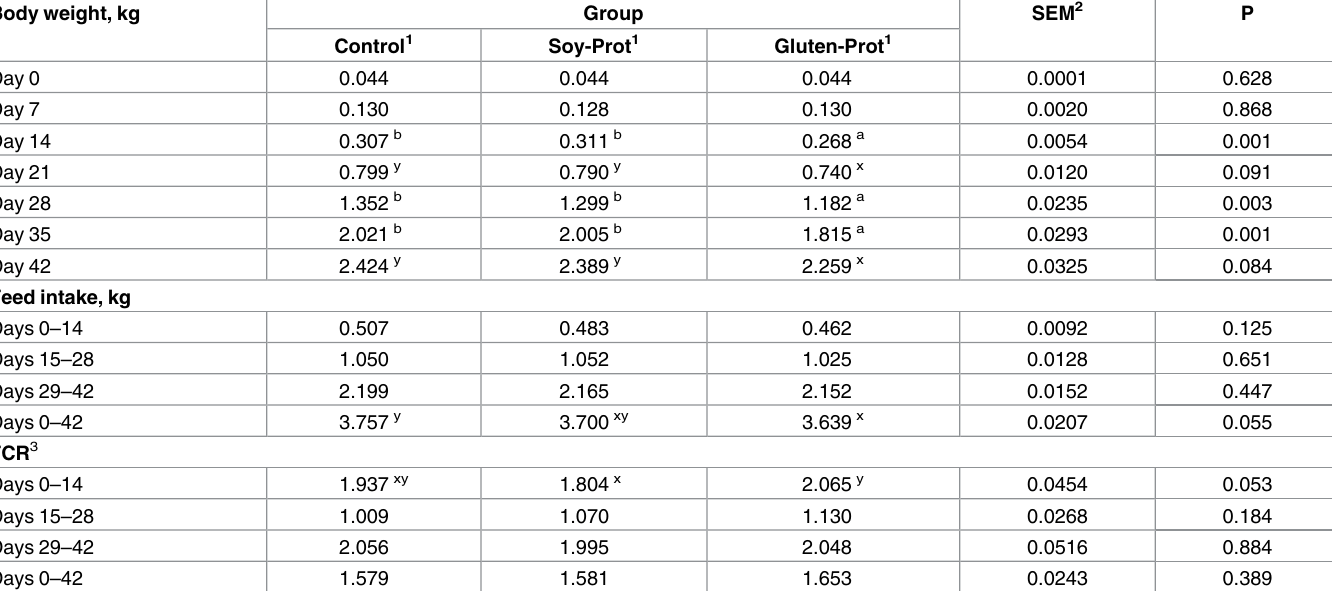
Table 5. Influence of diets on body weight, feed intake and feed conversion ratio of broiler chickens. Body weight,